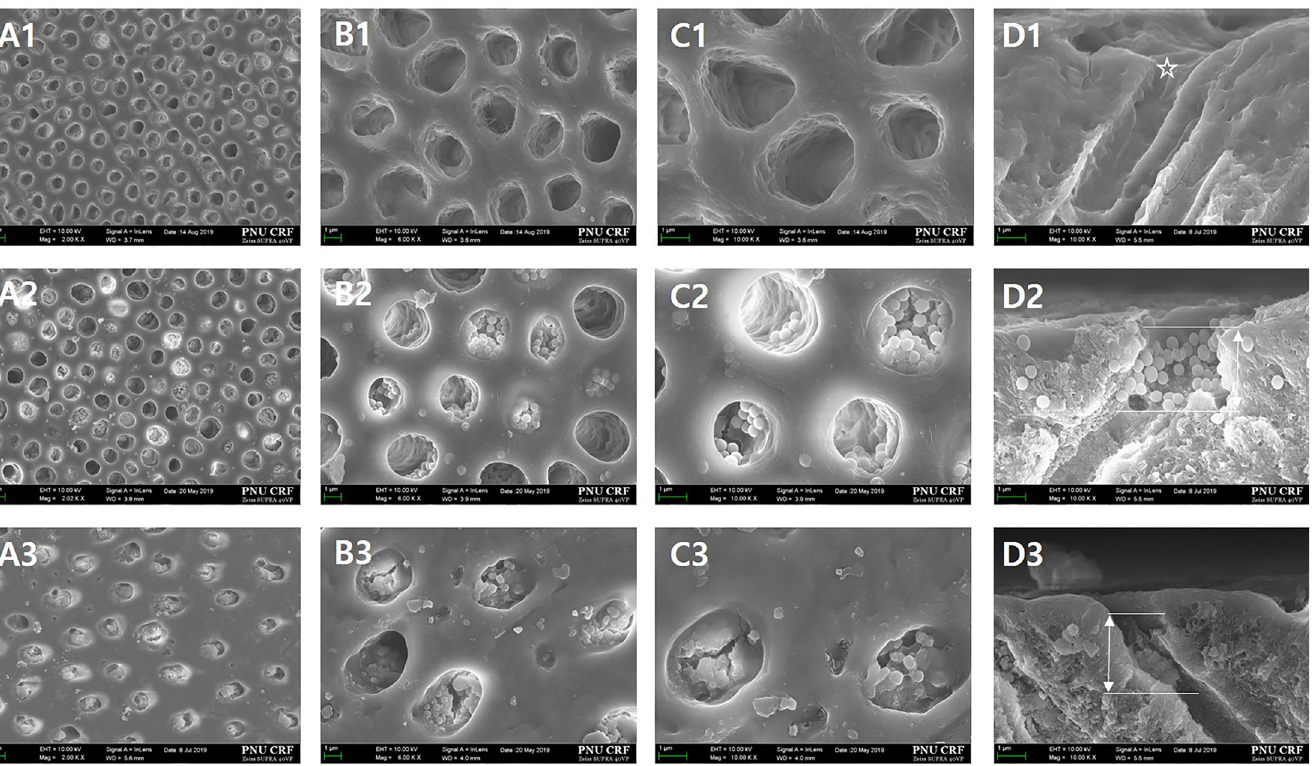
Fig 12. FESEM micrographs of the top and FESEM micrographs to examine the tubule-occluding effects in the hypersensitive tooth model after 1 min exposure to 6 wt.% citric acid (A, x2,000; B, x6,000; C, x10,000; D, sagittal). A1–D1 images of Group 1 (control) show that the diameter of the dentinal tubule increased ( � ). The image of Group 2 (dense BGN) shows that the concentration and depth of particles blocking the dentinal tubule have decreased. The image of Group 3 (MBGN) shows that there is a lower concentration of particles blocking the dentinal tubule and that the depth within the tubule has also decreased. Compared to those in Group 2, the particles in Group 3 aggregated and formed a membrane-like layer or box.